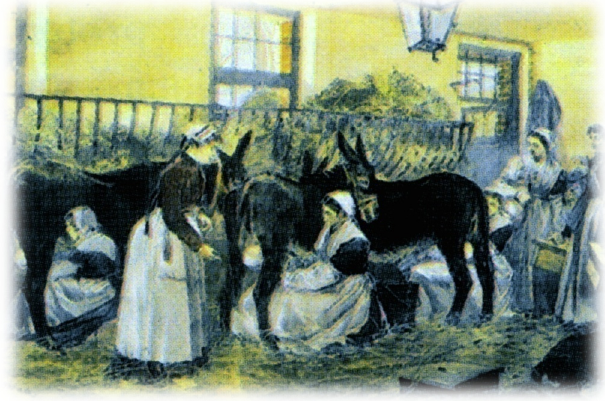
Figure 2. Collecting Ass’ milk. Hôpital St. Vincent de Paul. Paris XIX century.